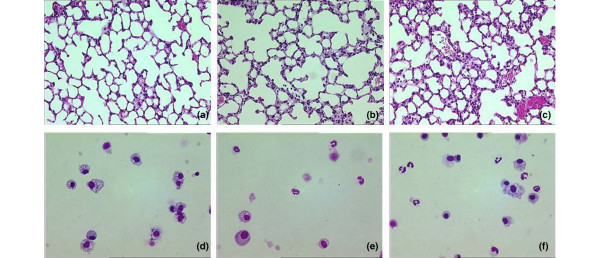
Histological specimens from the lungs of spontaneously breathing mice and mice ventilated with low/high tidal volumes. (a to c) Images of histological specimens from the lungs of spontaneously breathing C57Bl/6 mice (control) or ventilated with low tidal volumes (LVT) and high VT (HVT) for five hours. H&E stain; magnification 200×. (a) Control mice; (b) LVT mice; (c) HVT mice. (d to e) Images of citospin preparations of BALF of C57Bl/6 mice stained with Diff-Quick. (d) control mice; (e) LVT mice; (f) HVT mice.